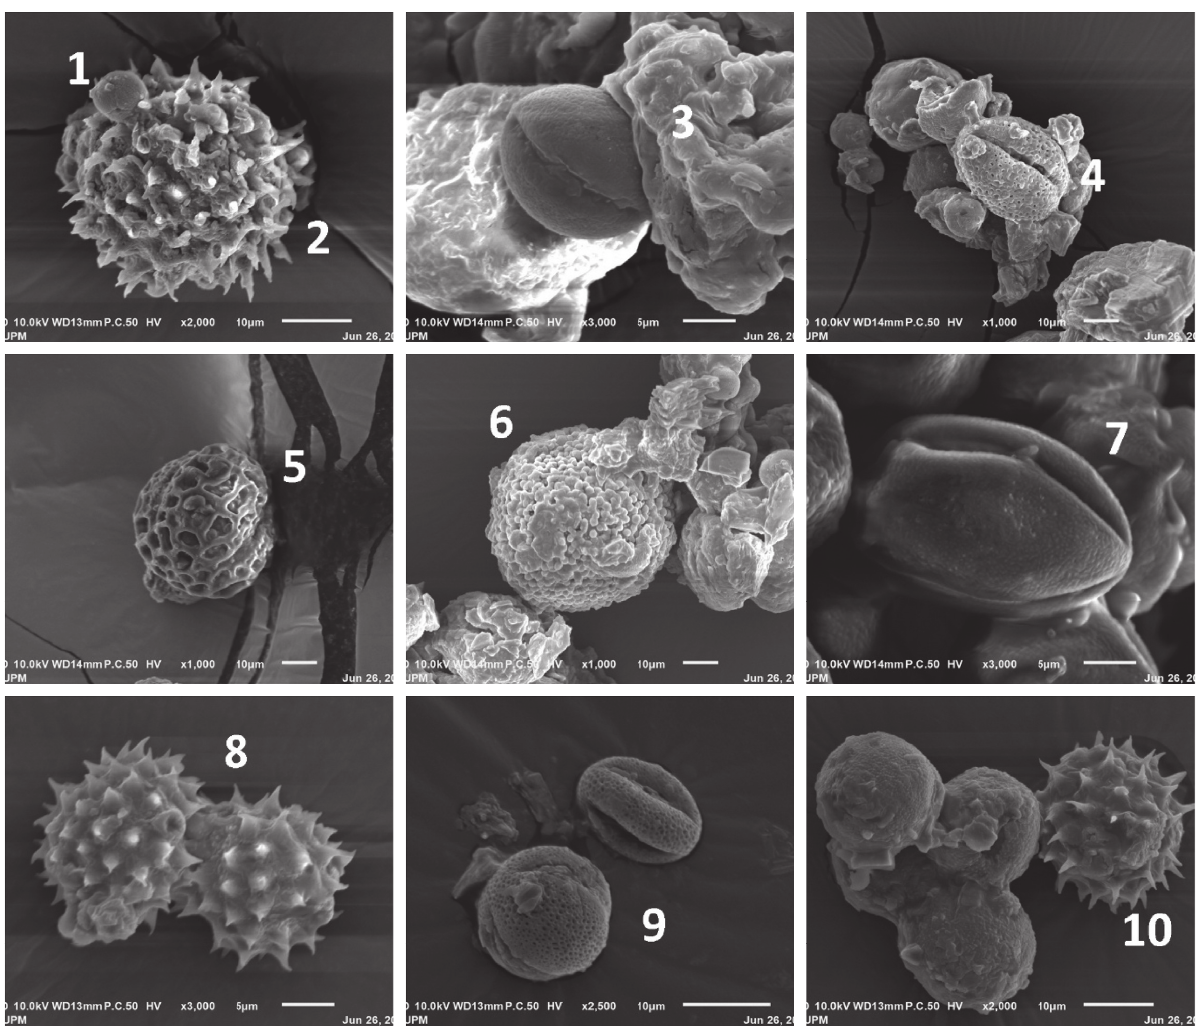
Figure 1: Pollen grains from H. itama bee bread: (1) Mimosa pudica , (2) Sphagneticola trilobata , (3) Cassia sp., (4) Areca catechu , (5) Peltophorum pterocarpum , (6) Phaleria capitata , (7) Cassia siamea , (8) Ageratum conyzoides , (9) Citrus aurantifolia , and (10) Bidens pilosa. Table 2: Physicochemical analysis of bee bread samples from four different geographical regions.